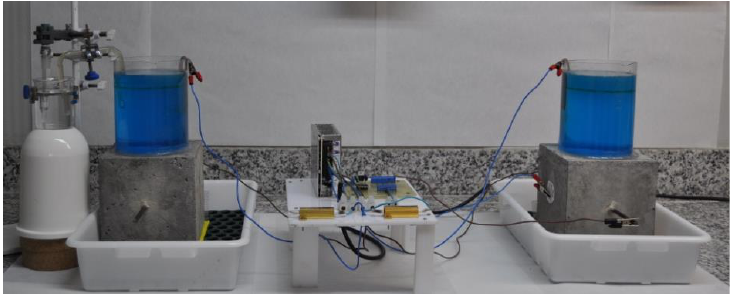
Figure 1. An assembly comprising two samples in parallel is used in the accelerated integral method.